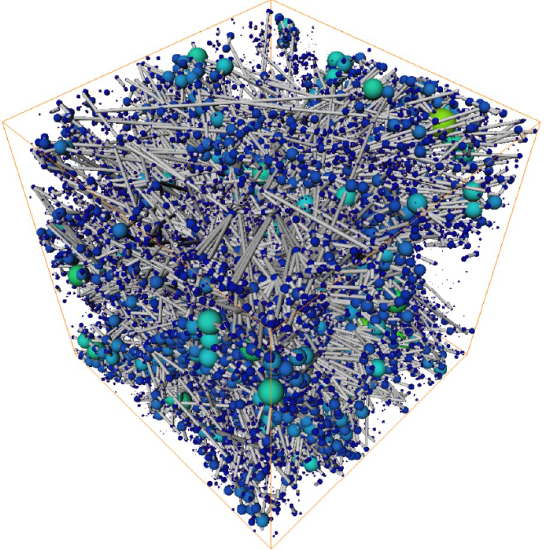
Figure 3. Visualization of the pore network 3D model generated from the pore-phase 3D model, in which pores are represented as a lattice of spheres connected by narrow cylinders—pore throats. The size of the pore or pore throat indicates the inscribed radius.